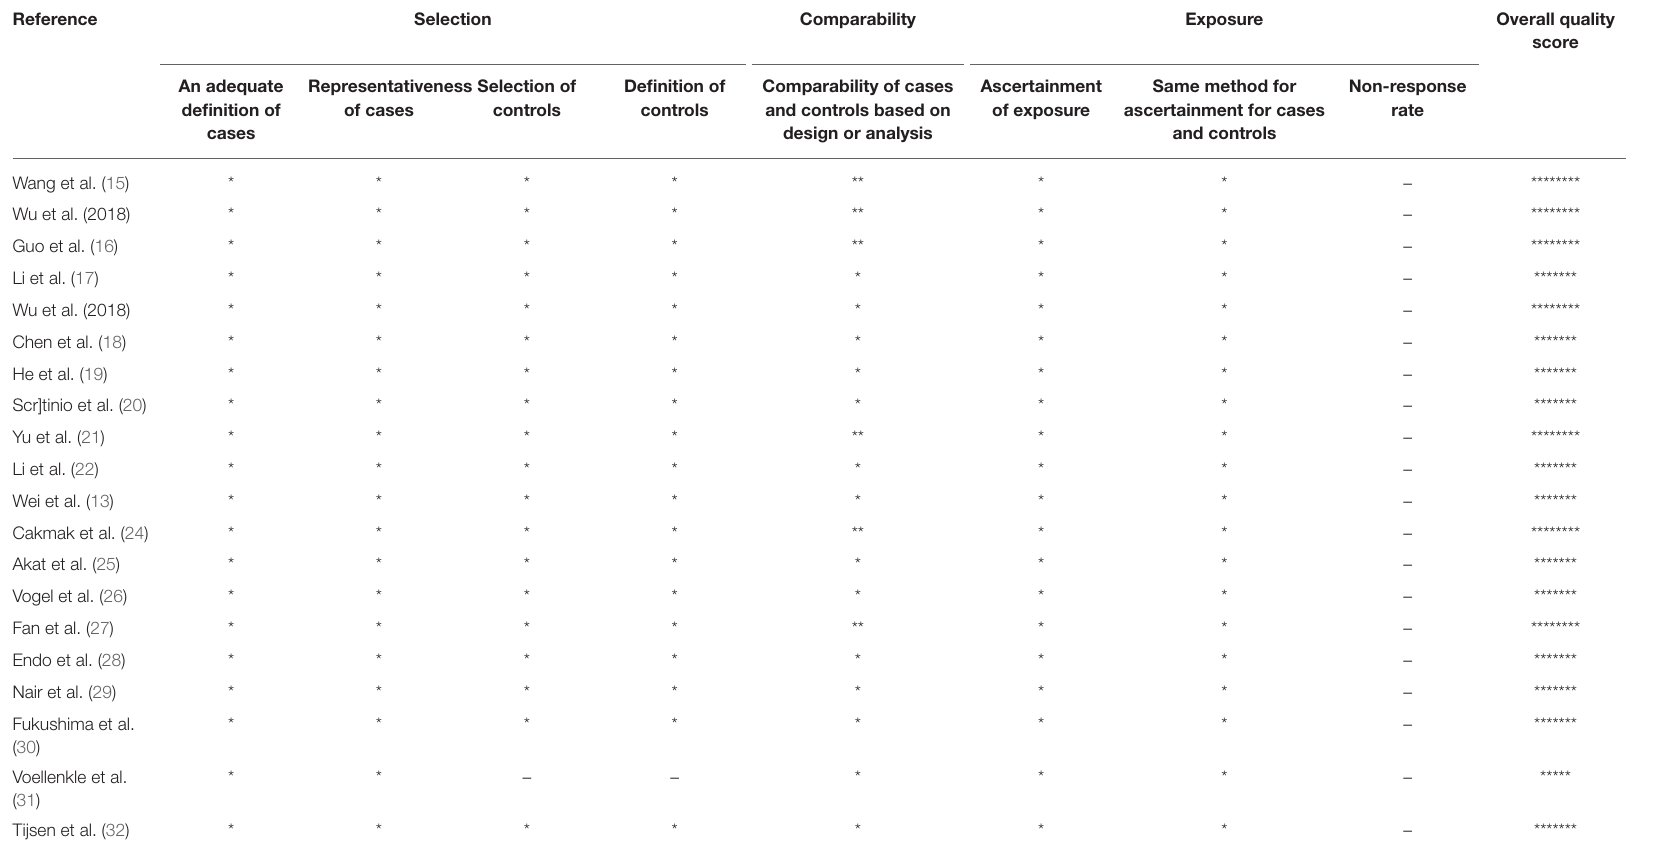
TABLE 2 | Quality assessment of included research papers using the Newcastle-Ottawa